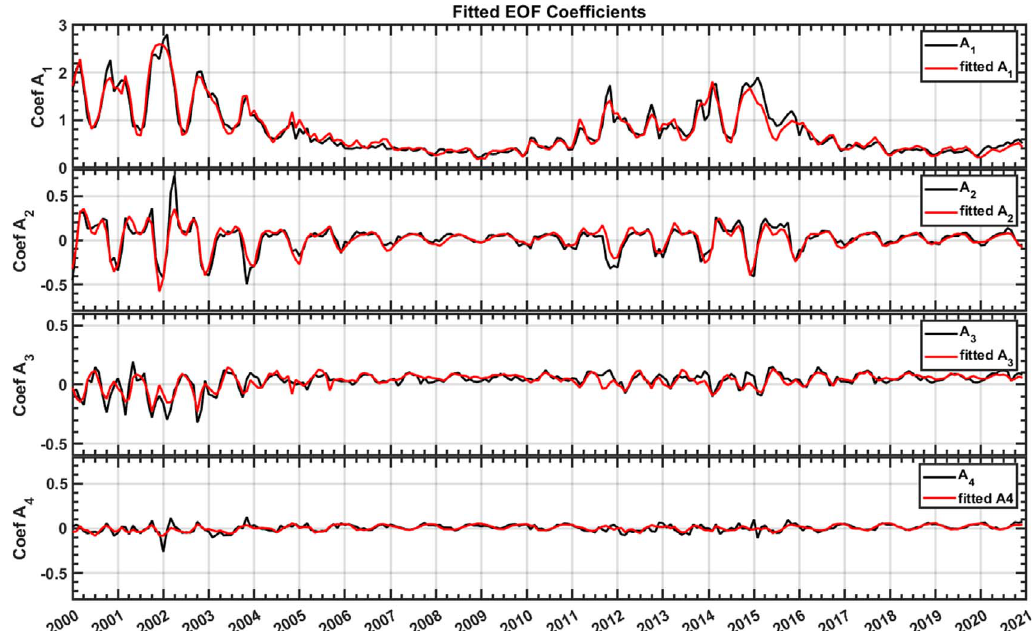
Fig. 6. The EOF coef fi cients and the fi tted coef fi cients using three selected parameters (see text for more